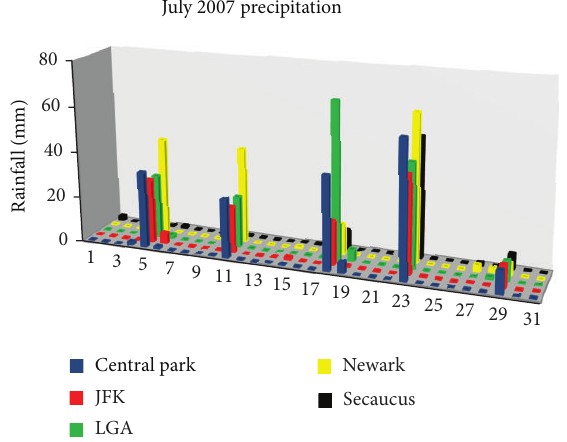
Figure 1: National Weather Service (NWS) data for various sites in the NYC/NJ region for July 2007.